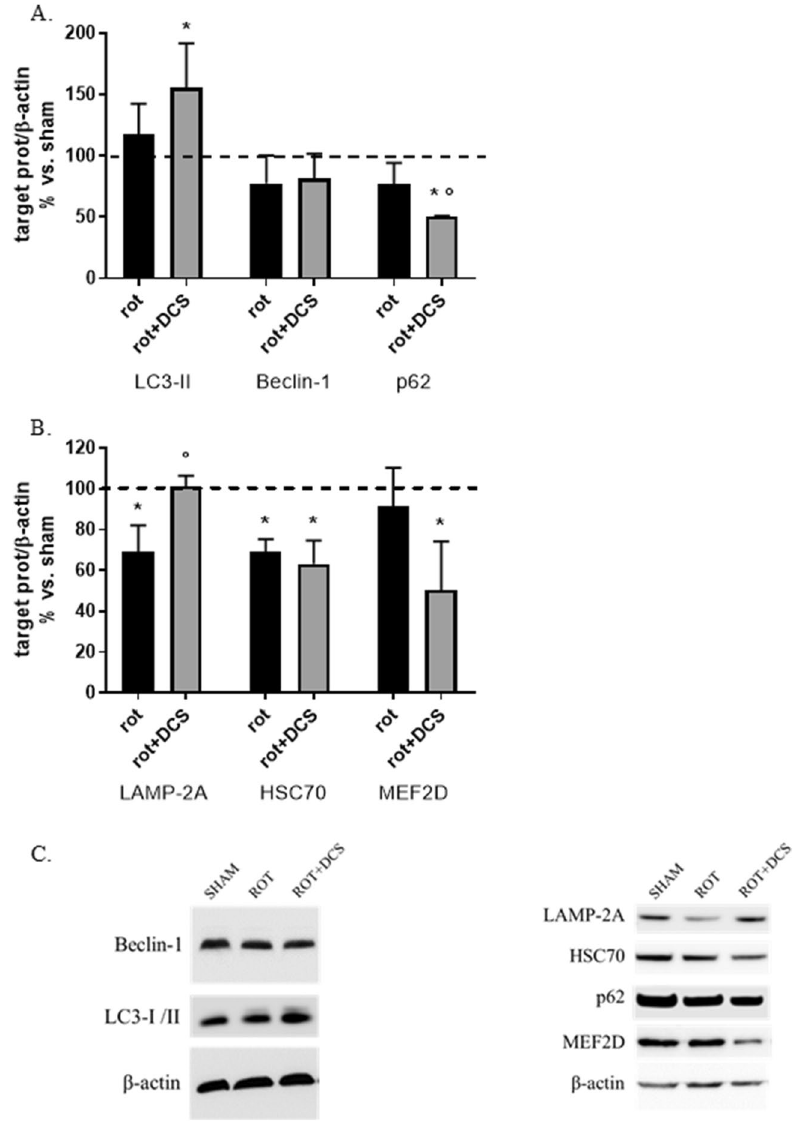
Figure 6. Effects of DCS on protein expression of macroautophagy ( A–C ) and CMA ( B , C ) markers in cells treated with rotenone (400 nM, 24 h); cells were collected 17 h after DCS (R17). An up-regulation of macroautophagy ( A–C ) and CMA ( B , C ) was found in rotenone-treated cells after DCS. ( C ) Representative Western blot images showing immunoreactivity for Beclin-1, LC3-I/II, LAMP-2A, HSC70, p62 and MEF2D and β-actin, used as internal standard, in sham-treated cells and cells exposed to rotenone alone or rotenone and DCS. Full-length blot or details on the used methodological approach are included in Supplementary M&M. (N = 3; *p < 0.05 vs. untreated cells, °p < 0.05 vs. rotenone-treated